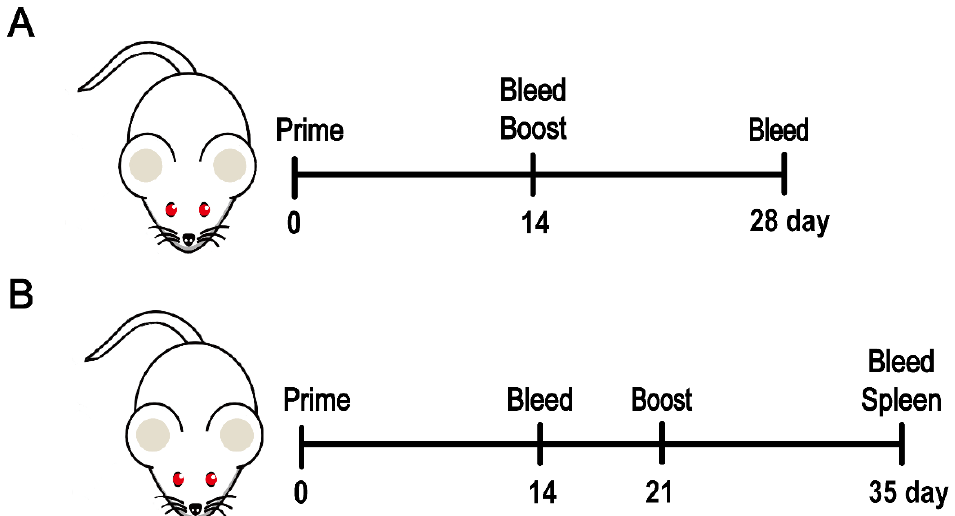
Figure 2. The detailed experimental procedure for the animal studies. ( A ) The animal study 1. ( B ) The animal studies 2 and 3.